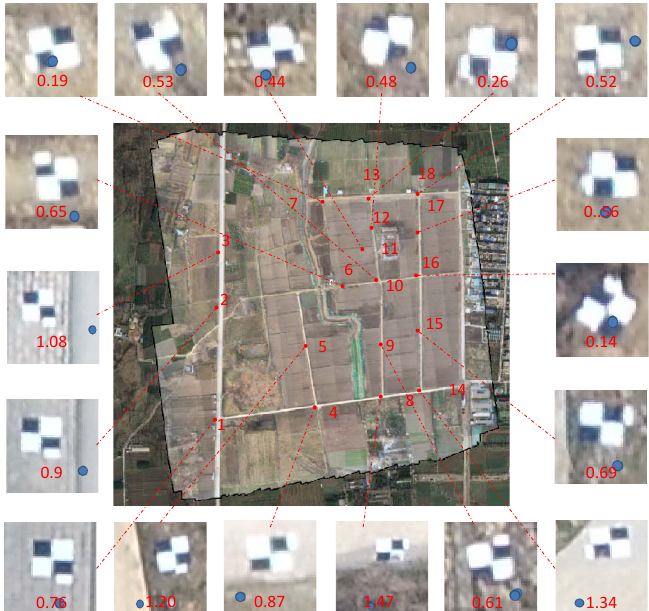
Figure 6. Detailed errors of GCPs in p4r-field dataset. The white–black marker size is 60 × 60 cm, and blue dot indicates the GCP location. The absolute error indicates the distance between the marker center and GCP position; it is measured in meters with red text. Since we organize the screenshots manually, so that the resolution may look not equal. Although the root mean square error (RMSE) of our method is slightly larger than Pix4DMapper and DJITerra, it is precise for most